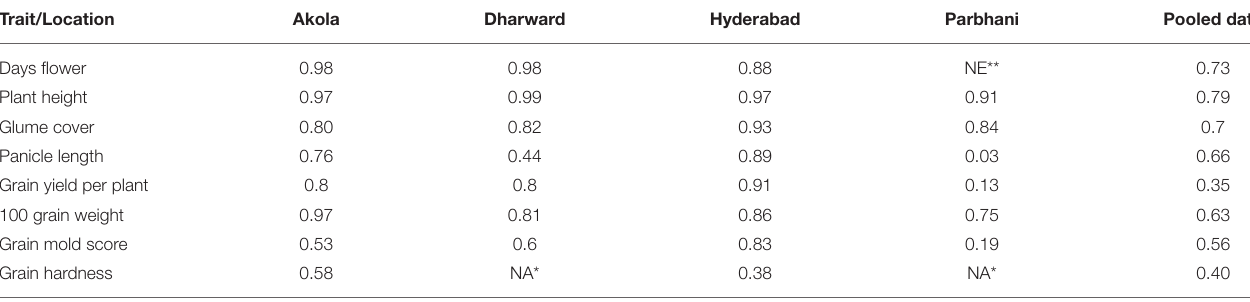
TABLE 4 | Broad-sense heritability (h 2 bs) for the traits location wise and across locations during the rainy season of 2018. Trait/Location